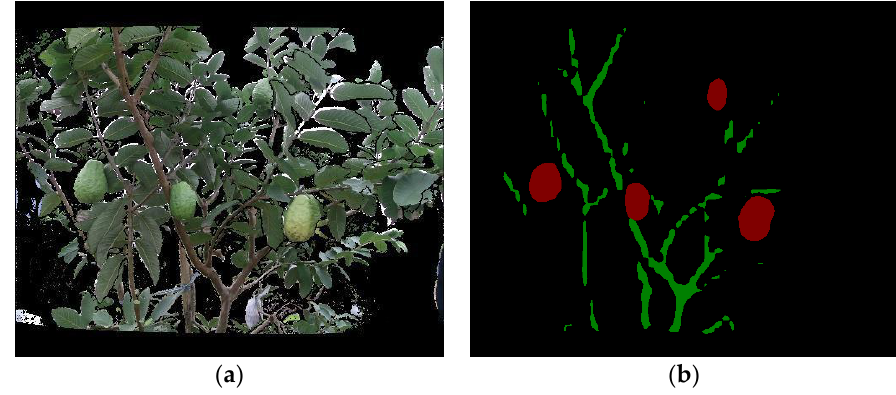
Figure 4. Segmentation results of the FCN model. ( a ) An aligned red–green–blue (RGB) image where black pixels represent objects outside the working range of the Kinect V2 sensor; ( b ) segmentation result where the red parts represent the fruits, and the green parts are the branches.